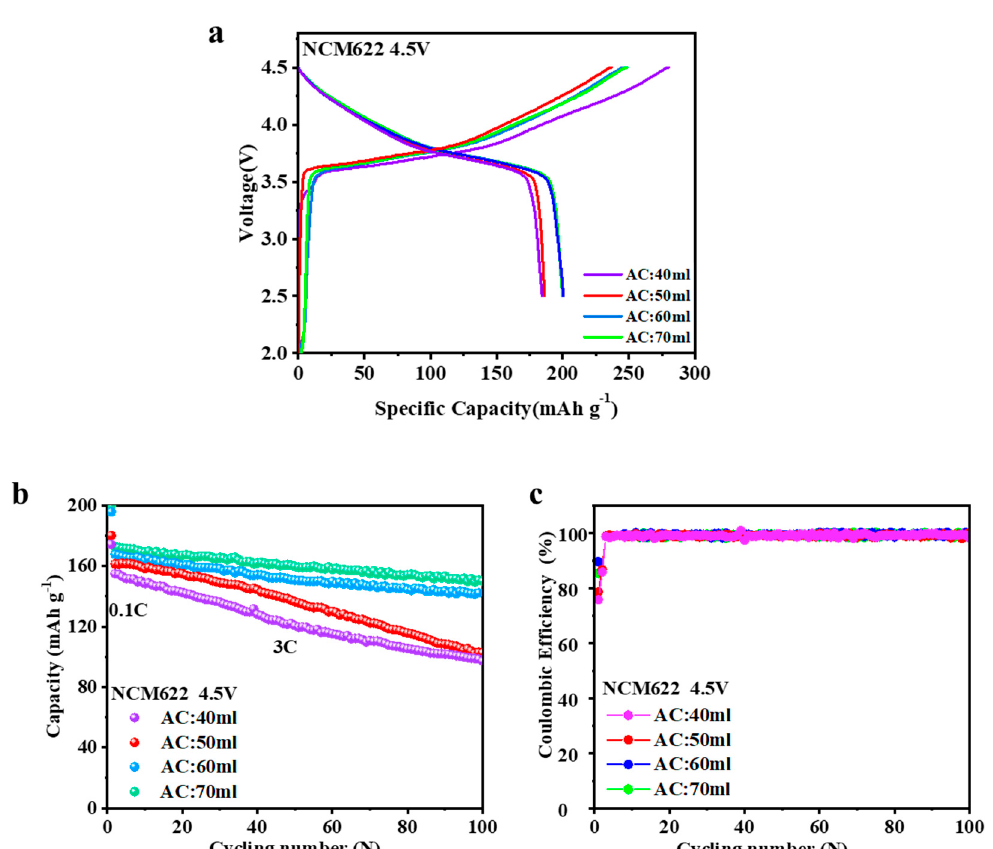
Figure 4. ( a ) Initial charge-discharge curves of NCM622 different ammonia content between 2.5 and 4.5 V at 0.1 C. Cycling stability of ( b ) discharge capacities and ( c ) coulombic efficiencies at NCM622 different ammonia content tested with voltage ranges of 2.5 − 4.5 V at 3 C. Table 4. Initial discharge parameters of NCM622 different ammonia content.